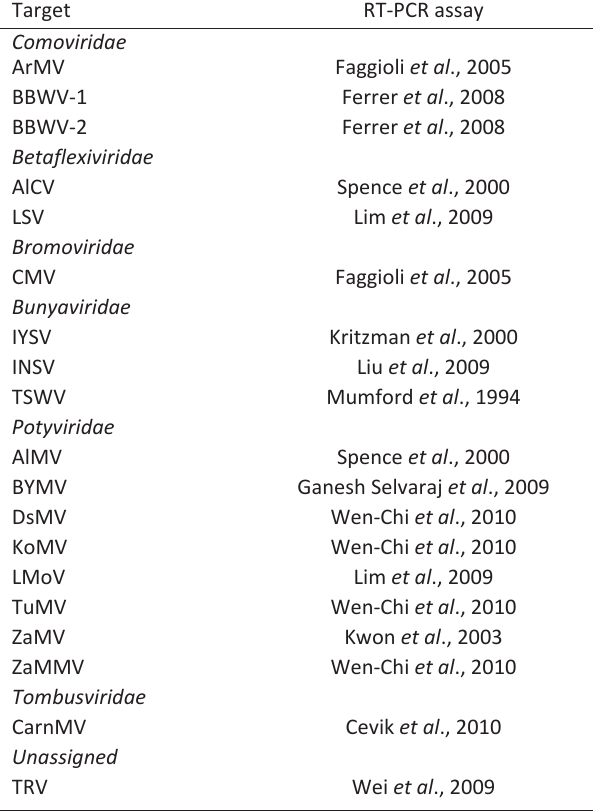
Table 1 - List of references for primers and RT-PCR conditions Target